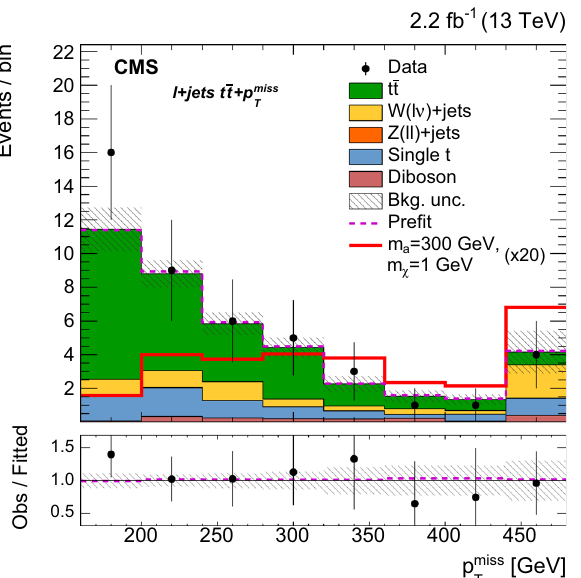
control samples are propagated to the efficiency scale